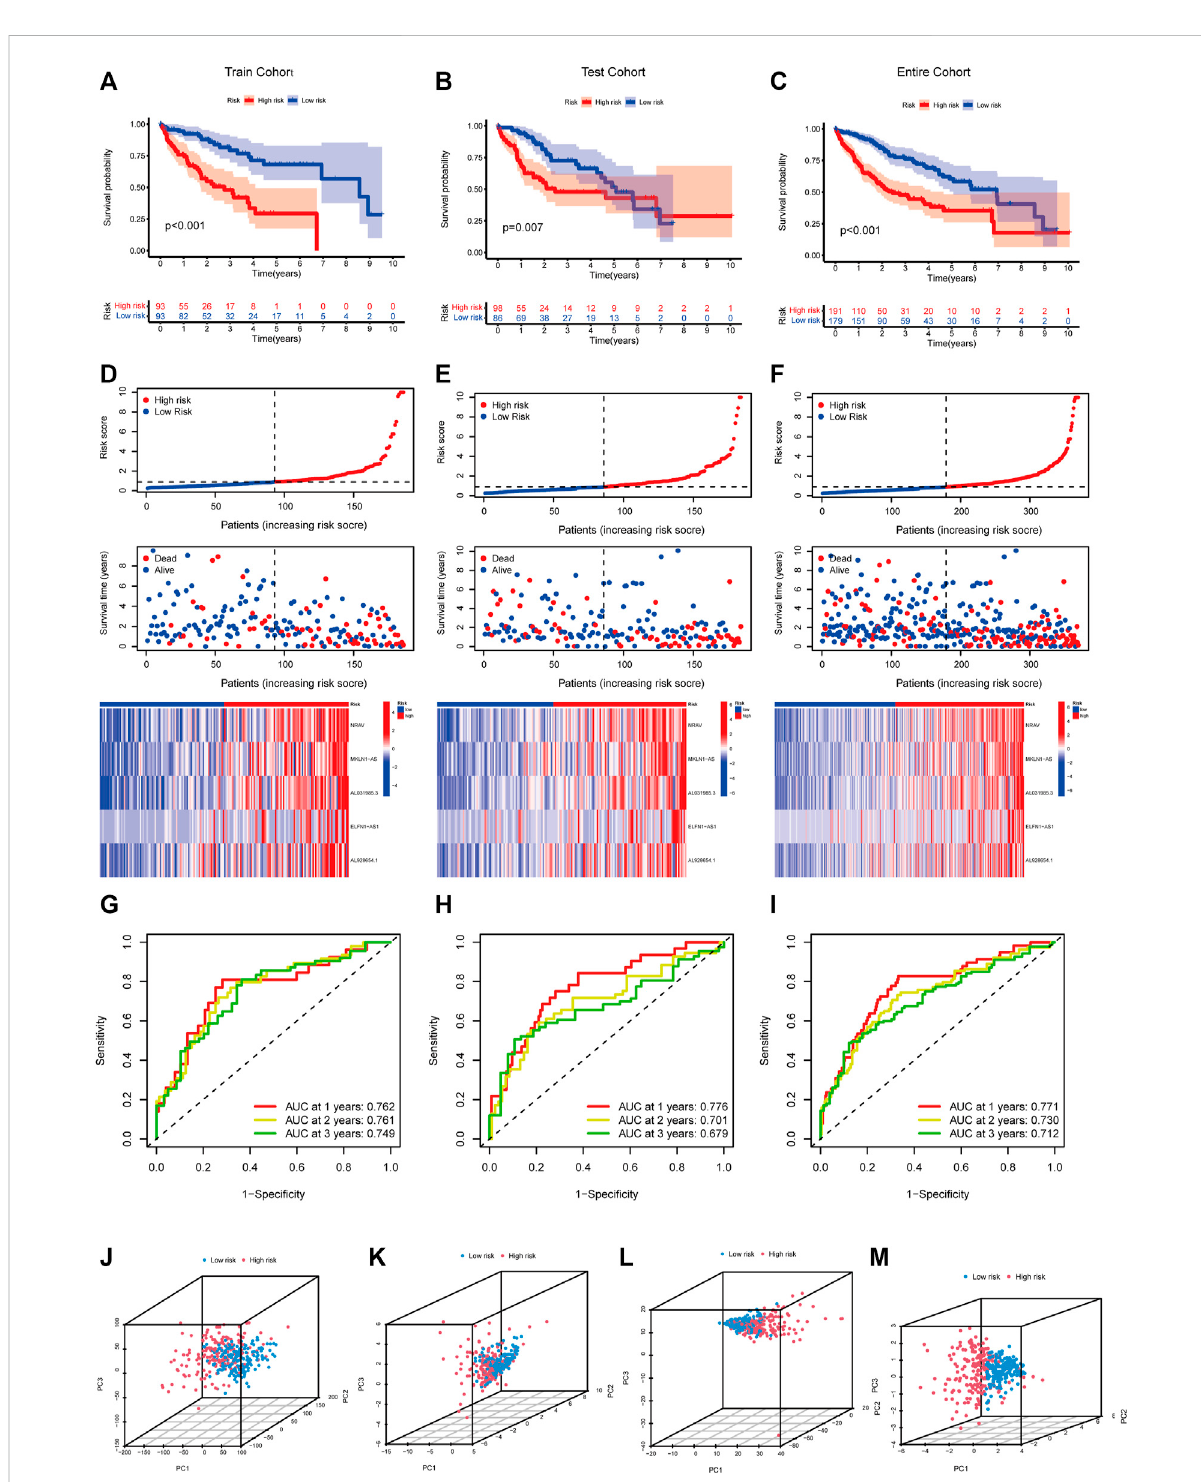
FIGURE 4 Veri fi cation of the m5C-lncRNA risk model. Kaplan-Meier curves of overall survival of high-risk and low-risk groups in the training cohort (A) , testing cohort (B) , and entire cohort (C) . The distribution of risk scores, survival status and expression matrix of fi ve-lncRNA signature in the training cohort (D) , testing cohort (E) , and entire cohort (F) . ROC curves of the model for OS prediction including 1, 2, and 3 years in the training cohort (G) , testing cohort (H) , and entire cohort (I) . PCA analysis between the high-risk and low-risk groups based on all genes (J) , m5C genes (K) , m5C- lncRNAs (L) , and risk lncRNAs (M)